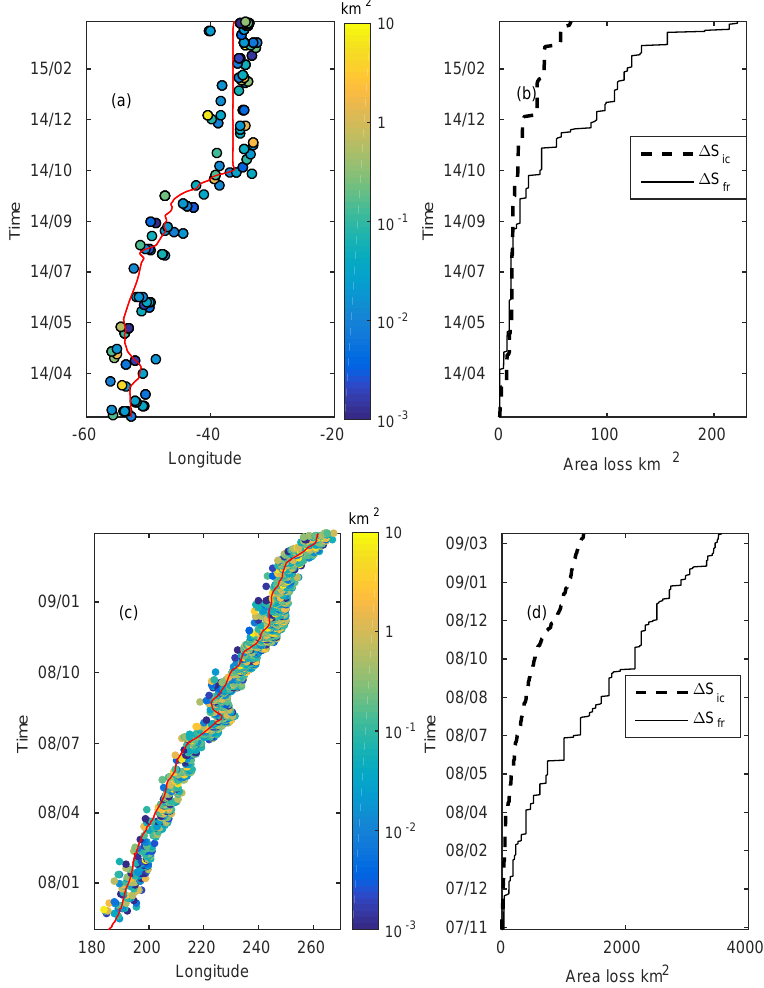
Figure 11. Time–longitude trajectory of B17a (a) and C19a (c) (red line) and coincident small icebergs detected in its vicinity. The colour represents the area of the iceberg in log scale. Surface loss by breaking (black lines) and surface of the detected small icebergs (dashed line) for B17a (b) and C19a (d)